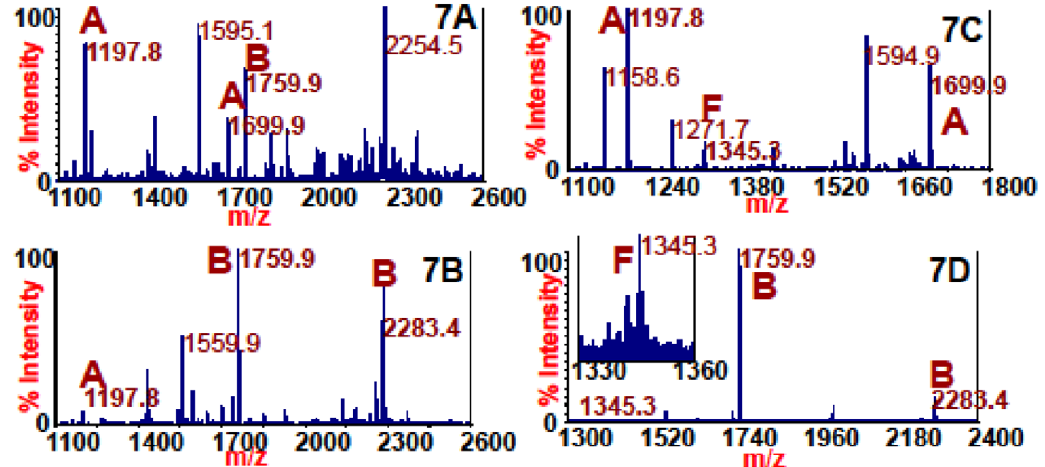
Figure 7. Mass spectra from the reaction of peptide substrates with 4E17.1 coated beads used to extract A2b (7A), Ba4 (7B), Af (7C), and Bf (7D). Peaks at m/z 1197.8 and 1699.9 indicate BoNT/A, peaks at m/z 1759.9 and 2283.4 indicate BoNT/B, and peaks at m/z 1345.2 and 3167.8 result from BoNT/F activity.